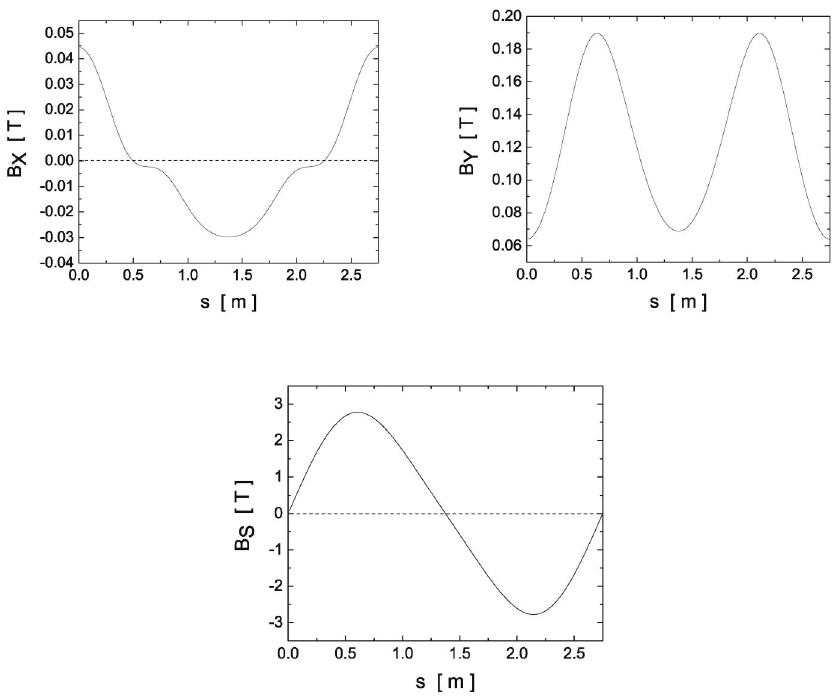
; (left); the vertical field B X